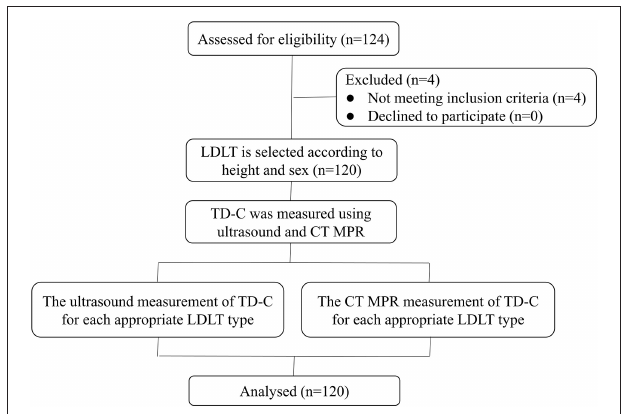
FIGURE 3 | Study flowchart of patients in the first part. TD-C, transverse internal diameter of cricoid cartilage; LDLT, left double lumen tube; MPR, multi-planar